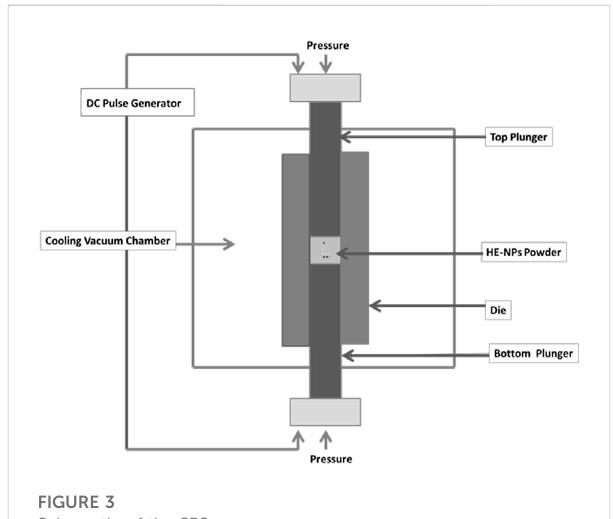
FIGURE 3 Schematic of the SPS